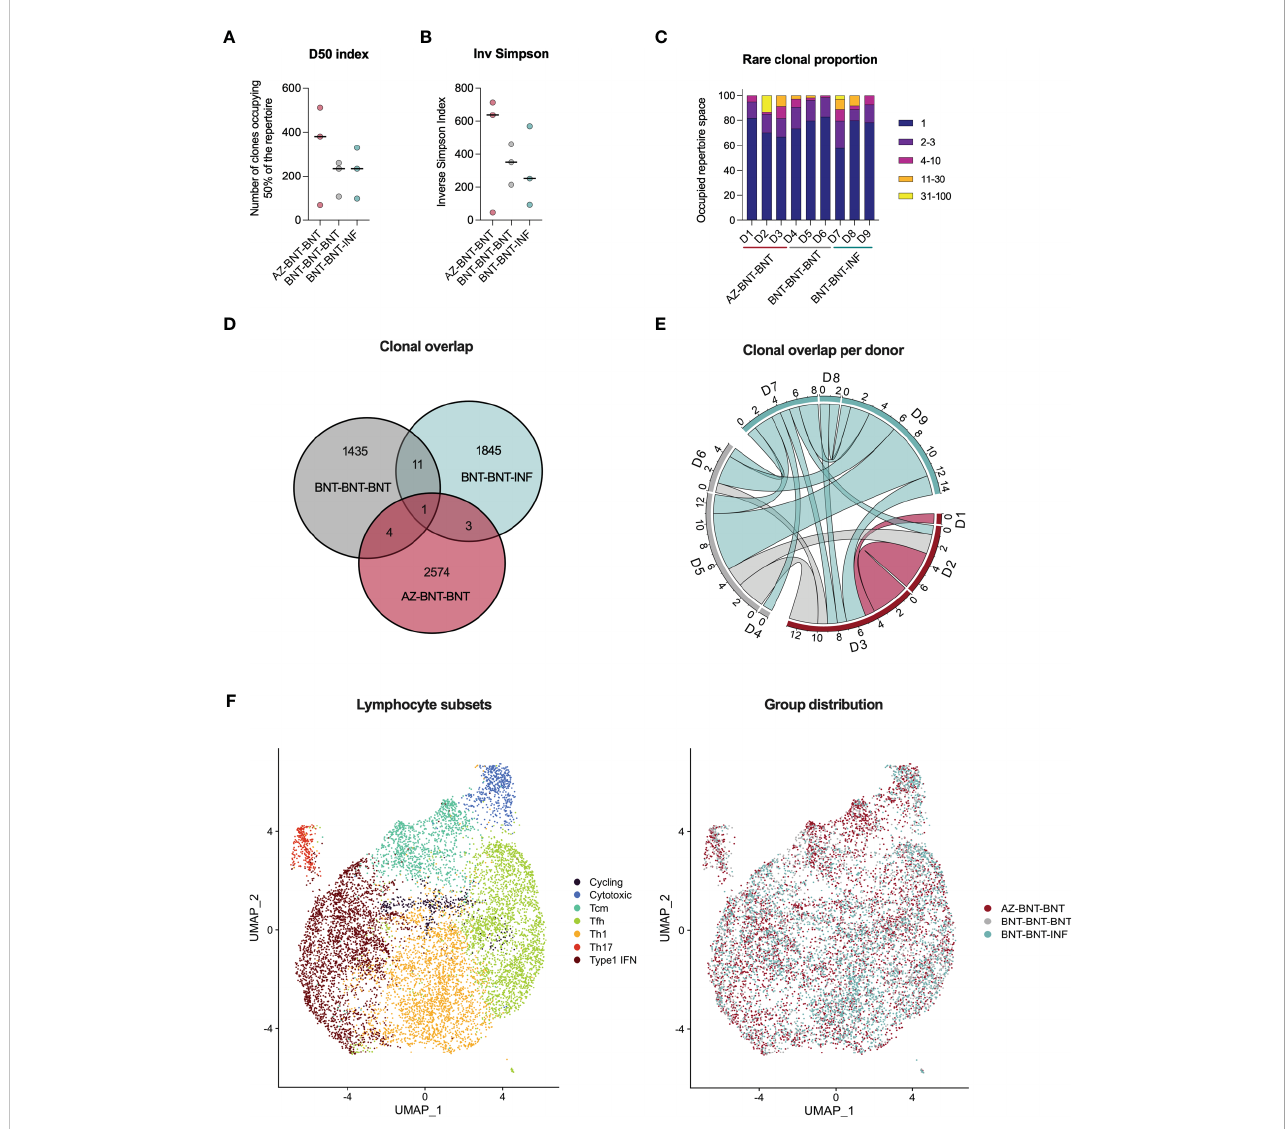
FIGURE 5 Three months post last antigen contact, single cell RNA sequencing of S-I-reactive CD4+ T cells reveals comparable TCR repertoire in heterologous (AZ-BNT-BNT) vaccinated, homologous (BNT-BNT-BNT) vaccinated and homologous vaccinated and infected (BNT-BNT-INF) individuals. (A) D50 index indicates the number of clones occupying 50 % of the repertoire. (B) Inverse Simpson Index indicates the TCR ab repertoire diversity. High values represent a more even distribution of clonotypes, whereas low values indicate enrichment of certain clonotypes. (C) Rare clonal proportion shows the summary proportion of clonotypes with speci fi c counts. (D) Venn diagram displaying the repertoire overlap between groups. (E) Circos plot giving the numbers of shared clones between samples of the different cohort. (F) UMAP clustering of seven lymphocyte subsets based on marker genes and distributions of groups across them. (A, B) Mann-Whitney test revealed no signi fi cant differences between groups ( P > 0.05). Black line indicates the